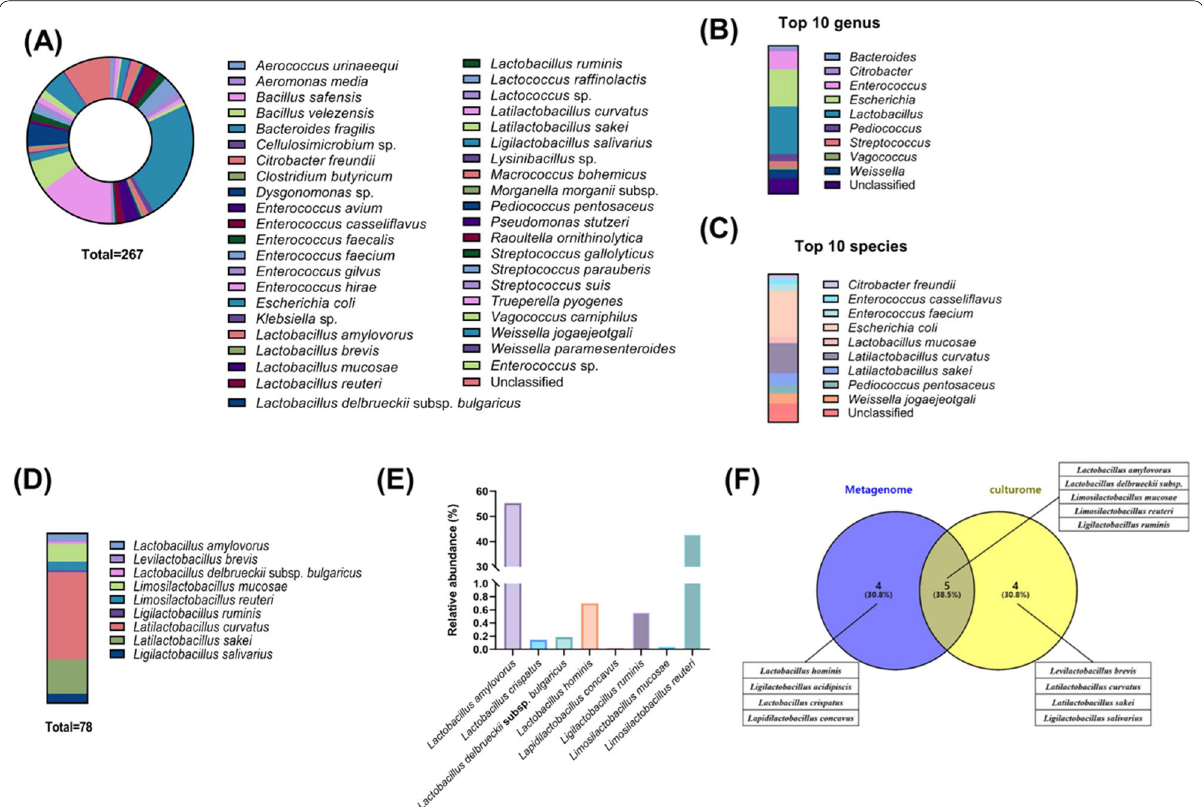
Fig. 3 Microbial characterization of MSP group utilizing culturomics and comparison analysis with metagenomics. A Identification of MSP group piglet fecal microbiota through culturomics approaches. B 10 dominant bacteria genus of MSP piglet fecal microbiota in culturomics approaches. C bacteria species. D Composition of Lactobacillus spp. detected from MSP piglet fecal microbiota through culturomics approaches. E Relative abundance of OTUs identifying Lactobacillus spp. F Venn diagram depicting the number of bacterial species identified by culturomics (yellow) and metagenomics (purple), along with the proportion of species detected by both approaches